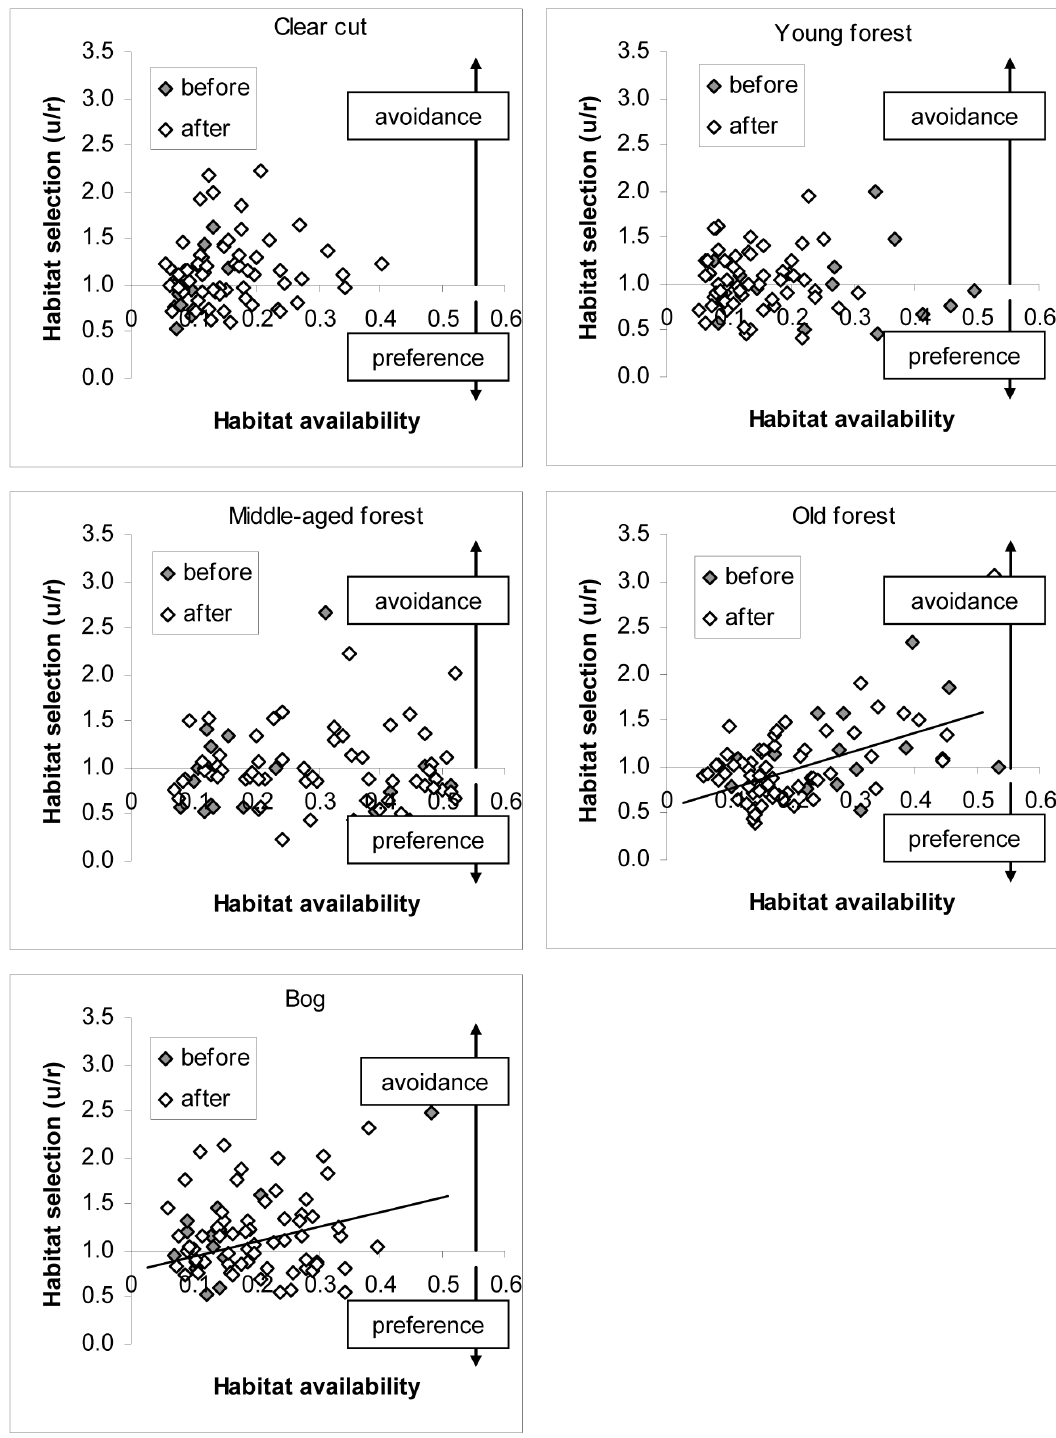
Figure 1. Habitat selection by roe deer at the spatial and temporal scales of home-ranges and seasons in relation to habitat availability at Grimsö Wildlife Research Area in 1984-2007. Trend-lines in figures illustrate the relationship between habitat selection and habitat availability for habitats in which this relationship was different from zero (the relationship between habitat selection and habitat availability was corrected for repeated observations of the same individuals). Random use is equal to one (i.e. a line following the x-axis). doi: 10.1371/journal.pone.0075469.g001 PLOS ONE |